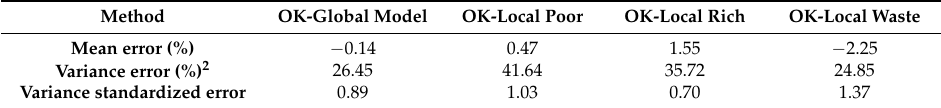
Table 4. Cross-validation comparison using local and global models.